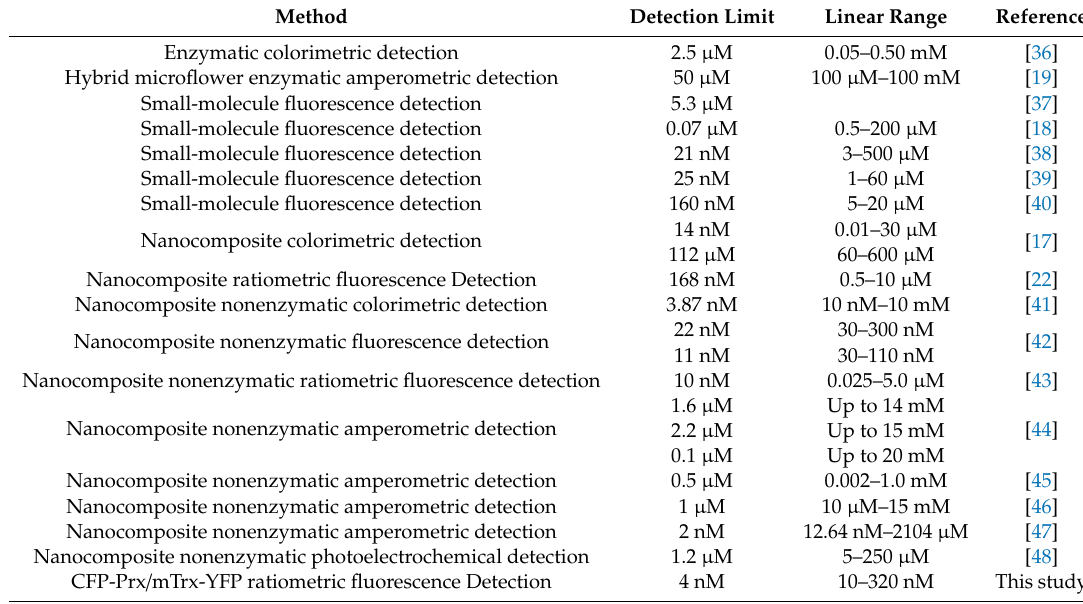
Table 1. Comparison of the performance of various H 2 O 2 sensors.